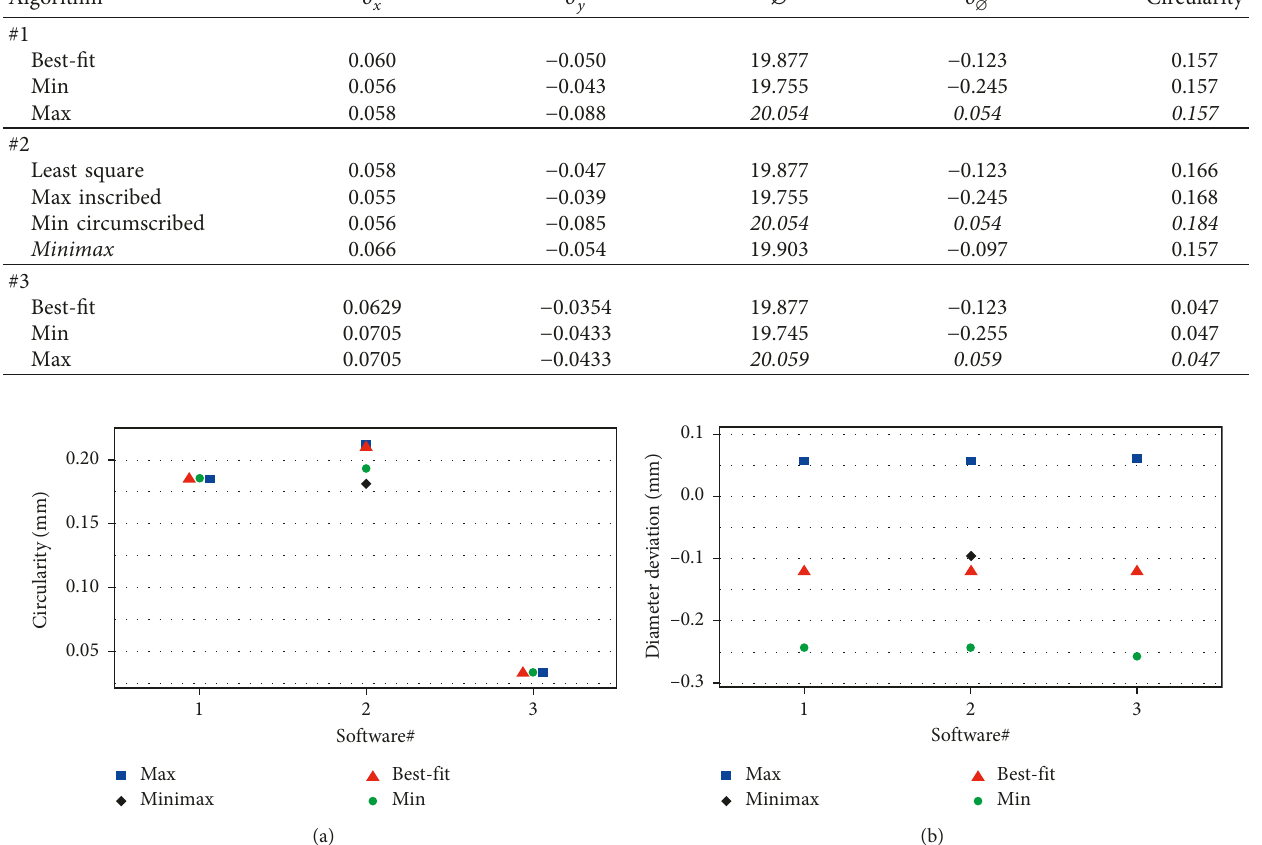
Figure 4: Results of the circle #2 analysis. (a) Circularity tolerance. (b) Feature of size deviation δ